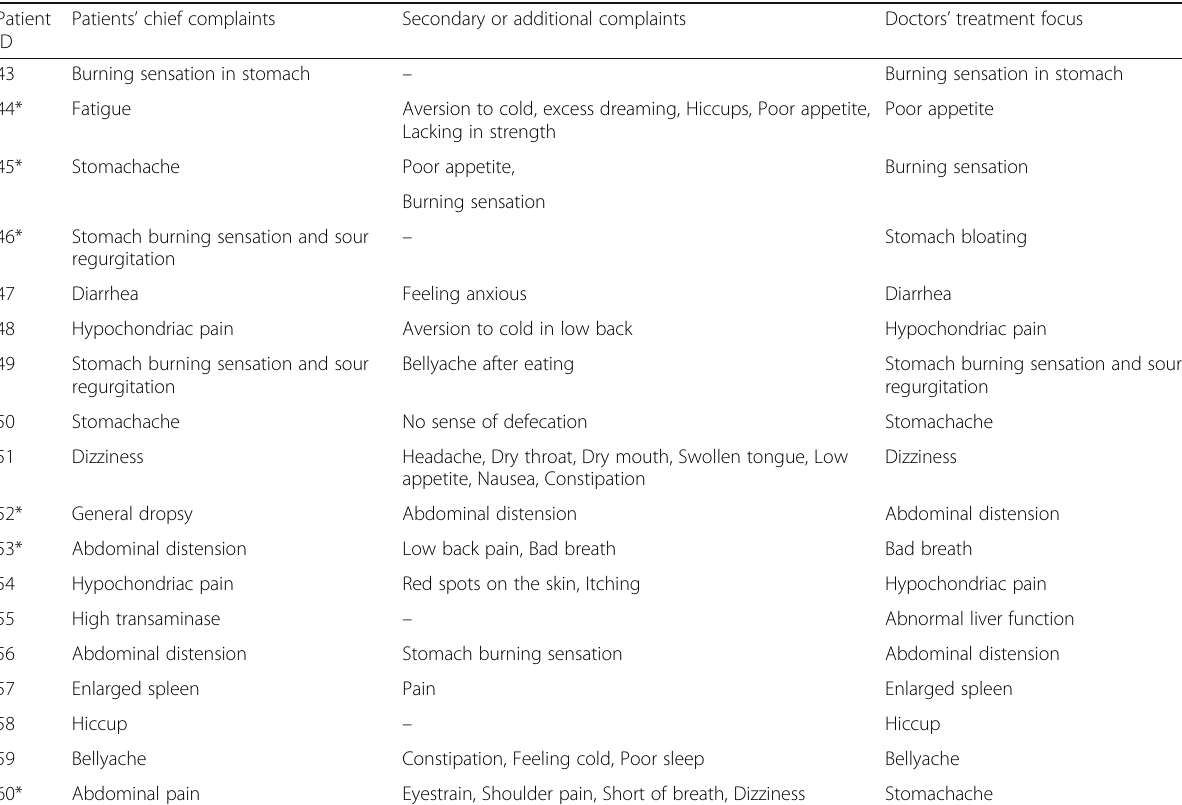
Table 3 Symptoms of Patients ’ Complaints and Doctors ’ Treatment (N = 60) (Continued) Patient Patients ’ chief ID